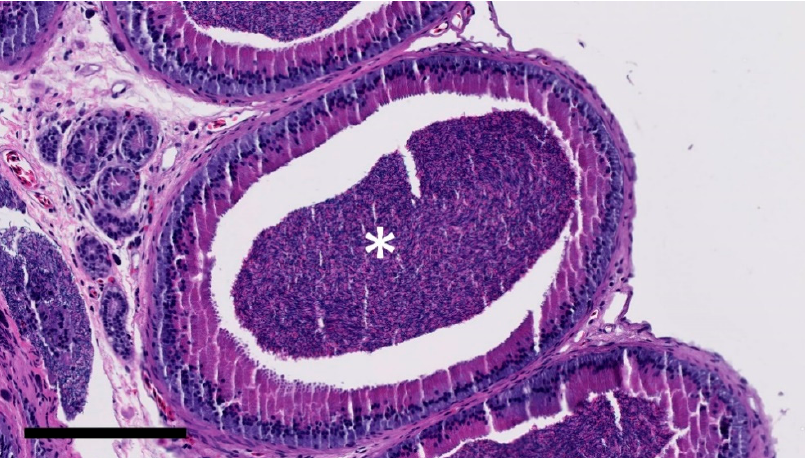
Figure 5. Abundant mature spermatozoa (white asterisk; grade 3/3) in epididymis of gecko receiving PMSG. Bar = 200 µm.